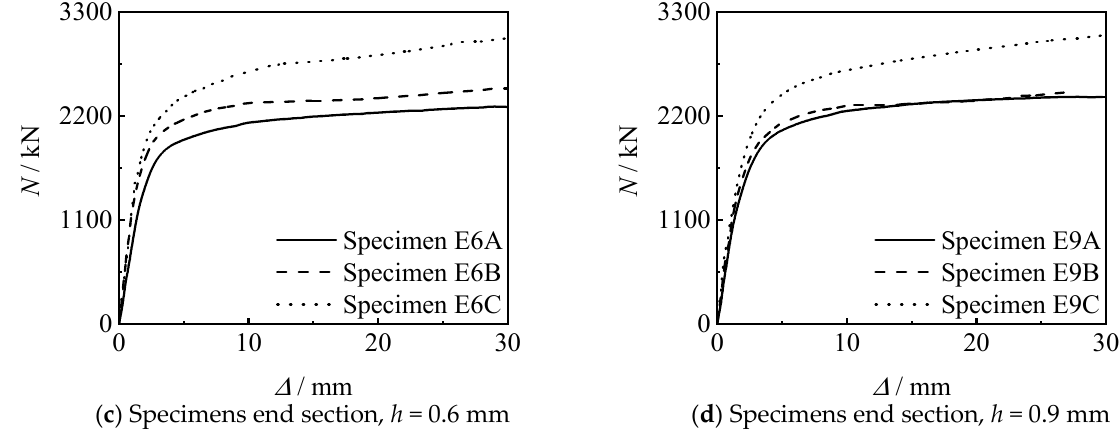
Figure 12. Effect of thread length on N- Δ curves of specimens.